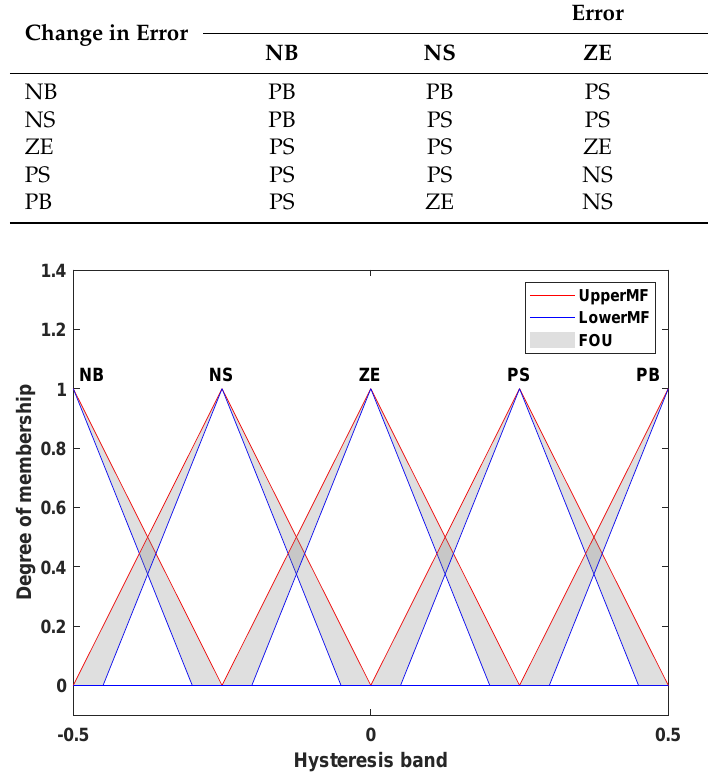
Figure 5. IT2FS membership functions for the output variable.